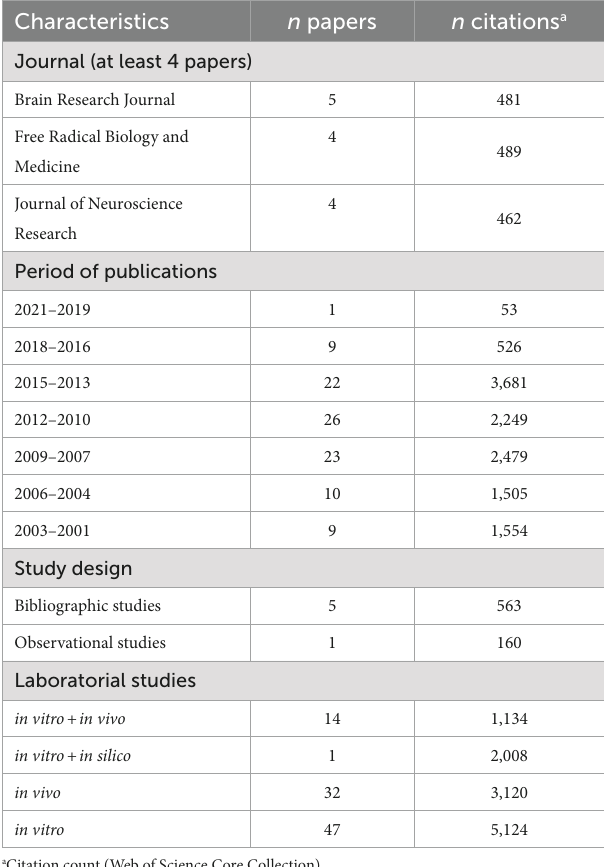
TABLE 3 Frequencies of characteristics of the 100 most-cited papers in PD and PC. Characteristics